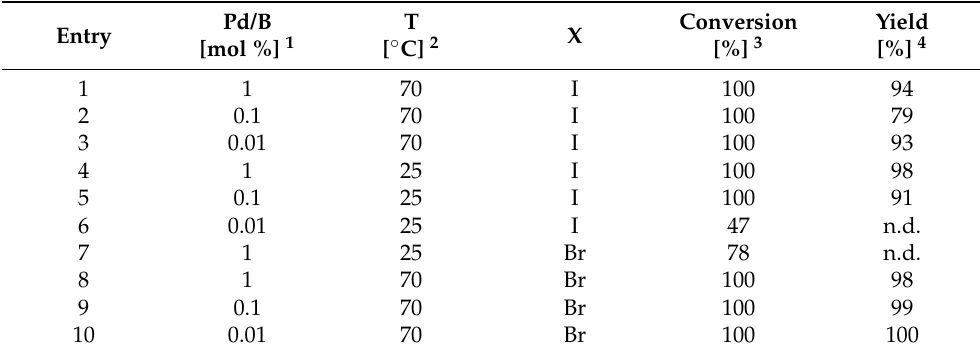
Table 1. Effect of catalyst loading, reaction temperature, and coupling partner on the conversion of the model reaction shown in Scheme 1.